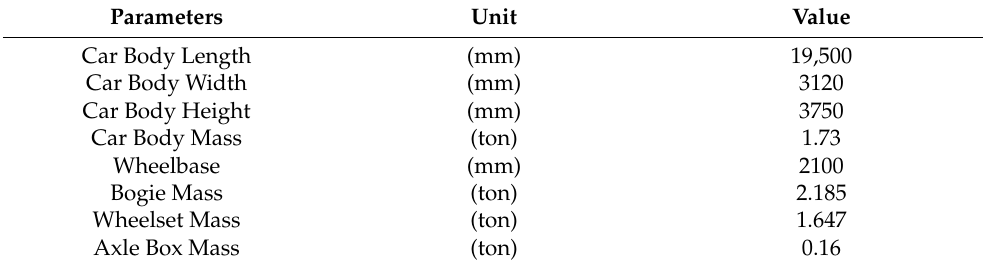
Figure 3. Bogie modeling. Table 2. Modeling values of length and mass.